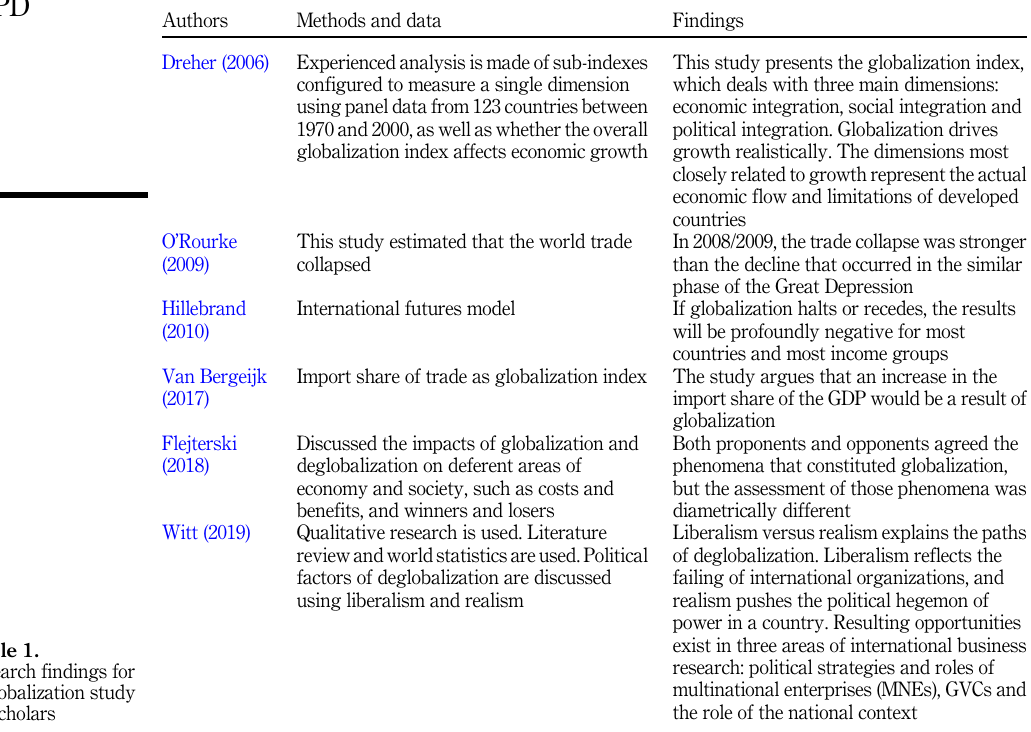
Table 1. Research findings